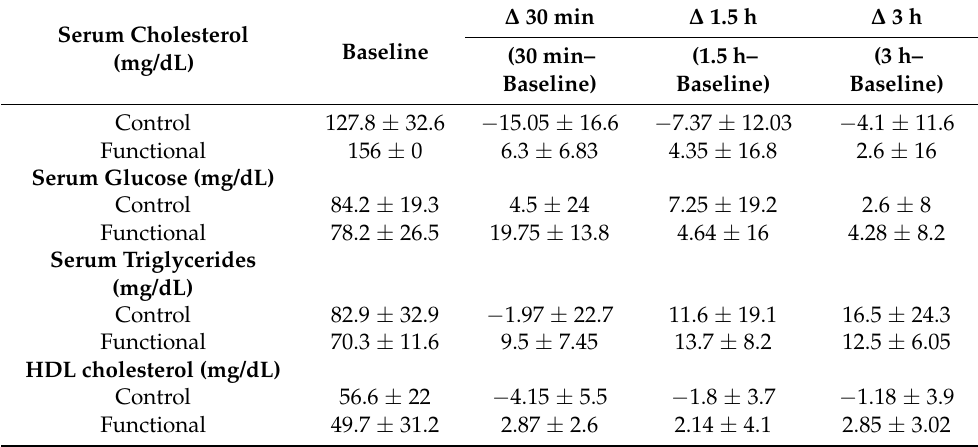
Table 4. Effects of Control and Functional meals on serum cholesterol, glucose, triglycerides, HDL and LDL cholesterol, uric acid levels, plasma antioxidant capacity and resistance to oxidation 30 min, 1.5 and 3 h after the